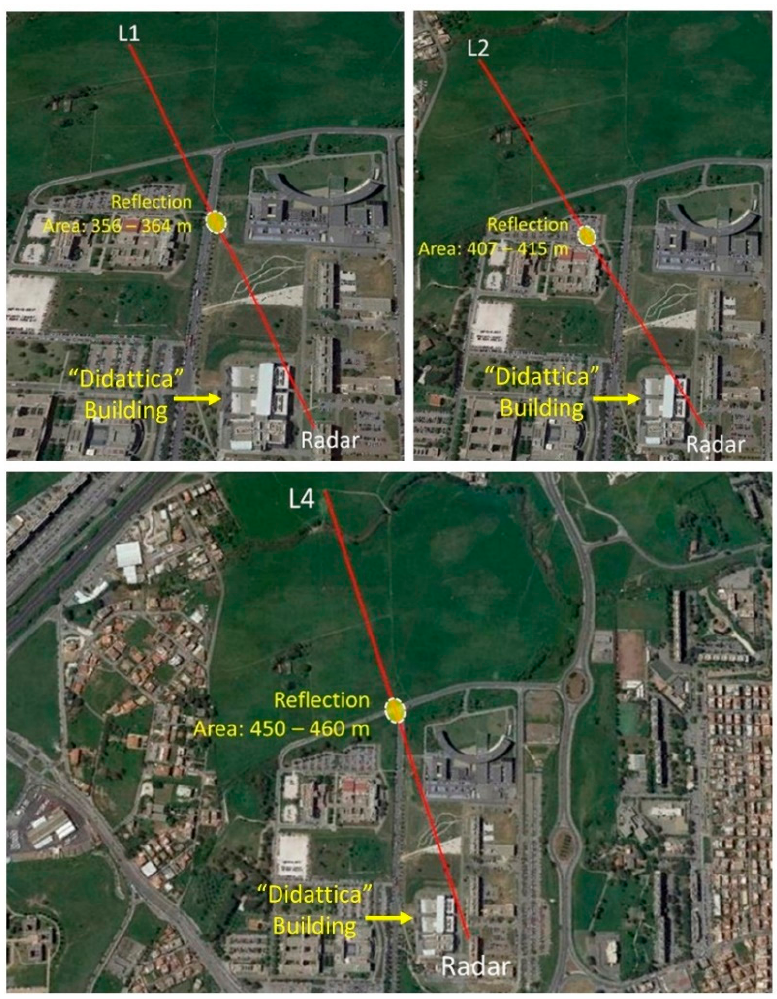
Figure 11. Reflection points on the ground for L1, L2, and L4.